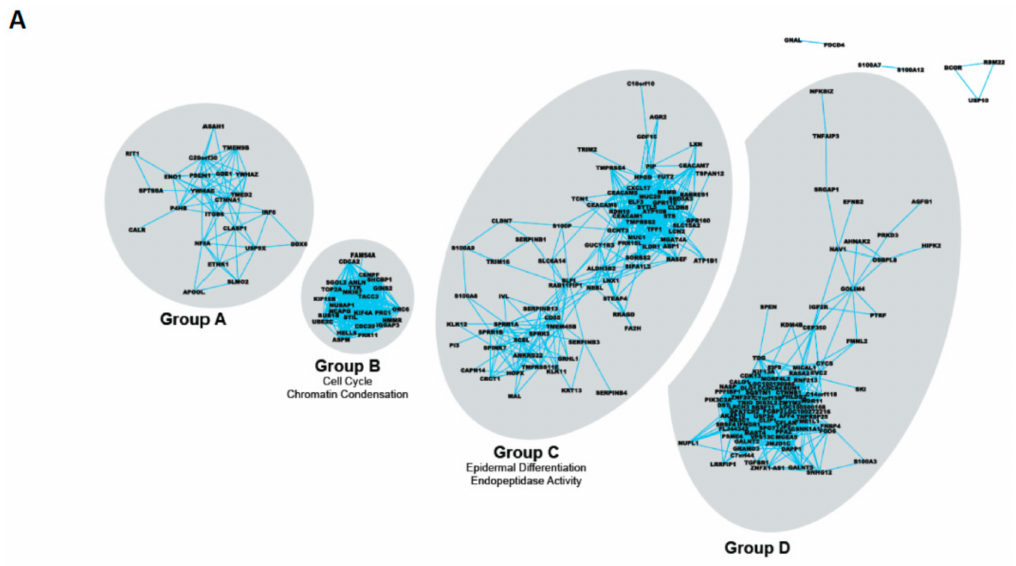
Figure 1. Cell phenotypes and the epigenetic landscape of normal human prostate epithelium ( A ) Epithelial Cell populations in a normal prostate, with the stem cell at the upper apex. It is important to note that the distinct cell types shown are simply representative and that the situation in a real tissue is much more plastic. Only the stem cell and the terminally di ff erentiated luminal cell have truly defined phenotypes. The remaining cells are part of a continuum of change. Various antigenic markers used to enrich for or identify cell populations are shown in the extreme right column. ( B ) Waddington’s epigenetic landscape (after Waddington 1940). The model emphasizes the continuum of the di ff erentiation process. The ultimate fate of a cell is to migrate to the base of the slope, as fully di ff erentiated luminal and neuroendocrine cells. The reversibility of the di ff erentiation continuum, to a stem cell fate from fully di ff erentiated cells, requires “energy” or multiple gene mutations / activations to promote a cell “upwards” to the stem cell (SC)